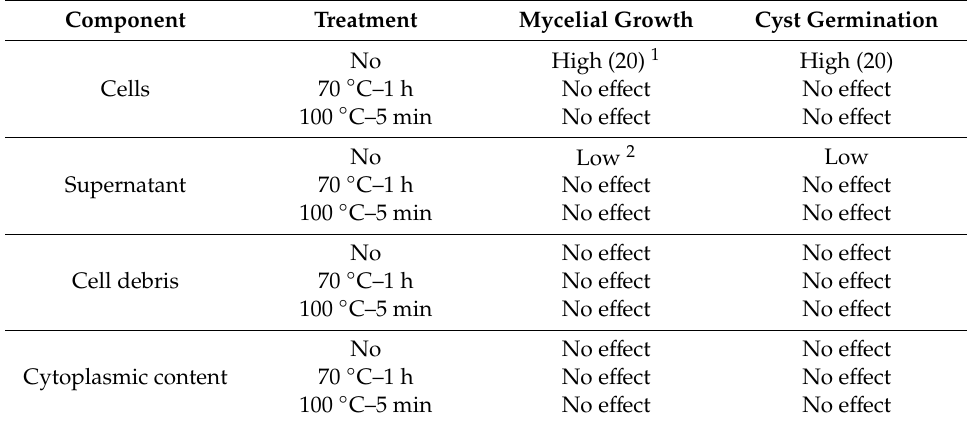
Table 3. Inhibitory activity of the cells, supernatant, cell debris and cytoplasmic content of Psudomonas fluorescens LE89 (without heat treatment, treatment at 70 °C – 1 h or treatment at 100 °C – 5 min) on mycelial growth and cysts germination of Saprolegnia parasitica .